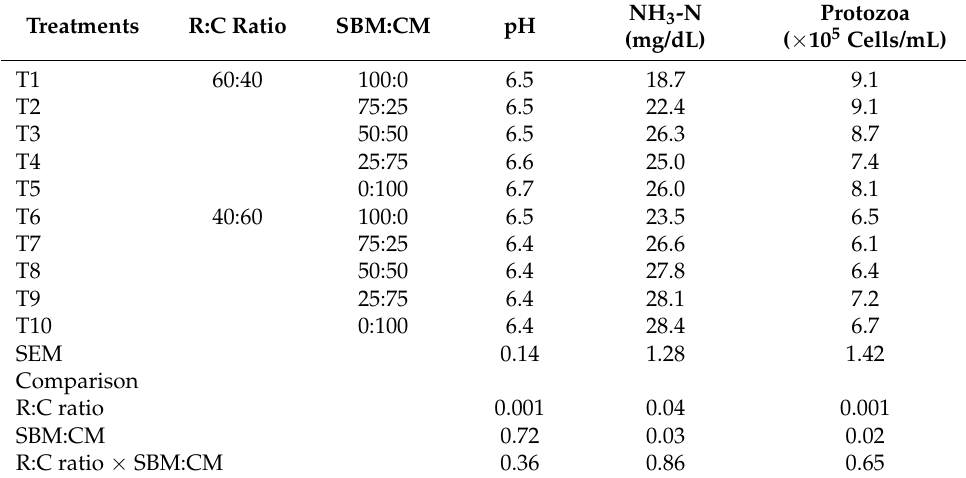
Table 4. Effect of cricket meal ( Gryllus bimaculatus ) (CM) in in vitro on rumen pH, ammonia–nitrogen (NH 3 -N) concentration, and protozoal